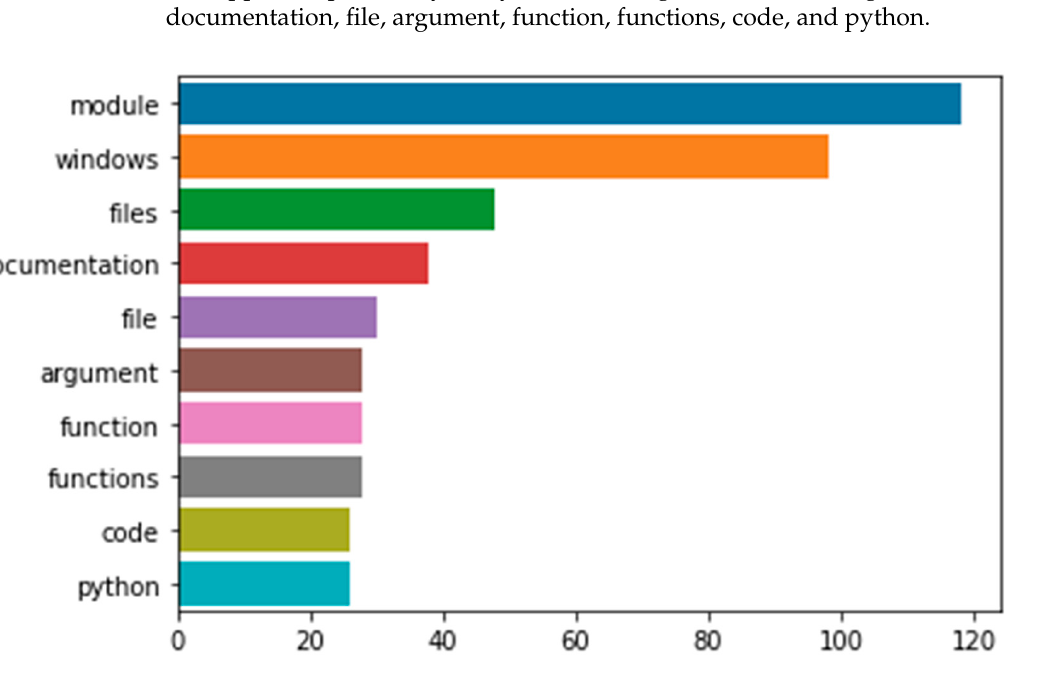
Figure 2. Bar chart of attribute “type”.